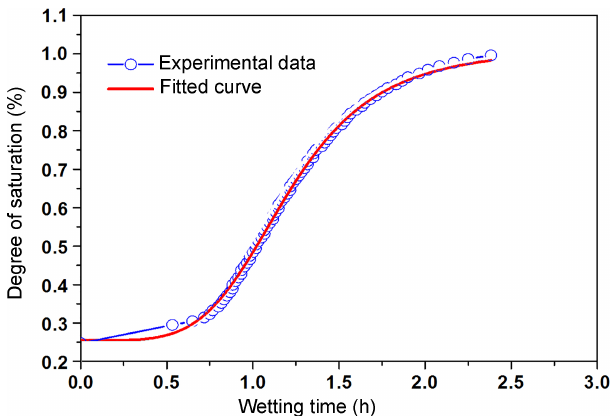
Figure 10. Wetting test for the strongly fragmented two mica-quartz schist